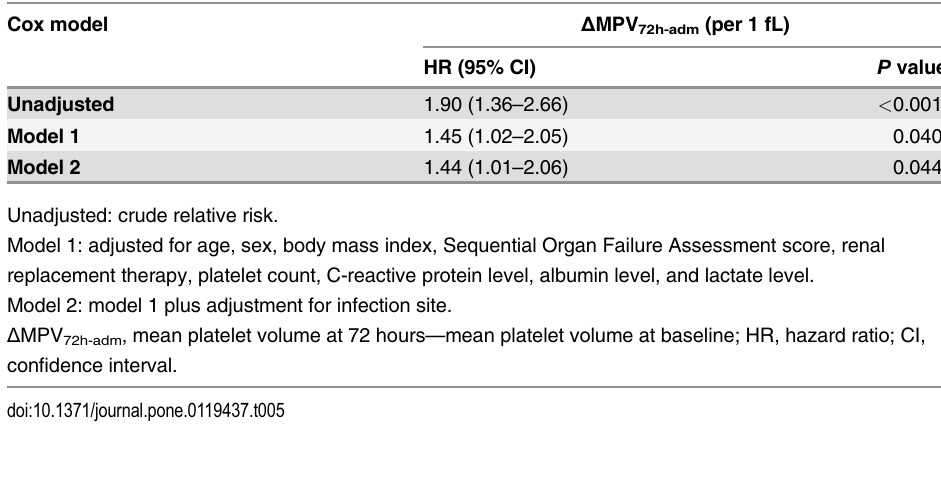
Table 5. Multivariate Cox proportional hazards analysis for 28-day all-cause mortality. Cox model Δ MPV 72h-adm (per 1 fL) Unadjusted Model 1